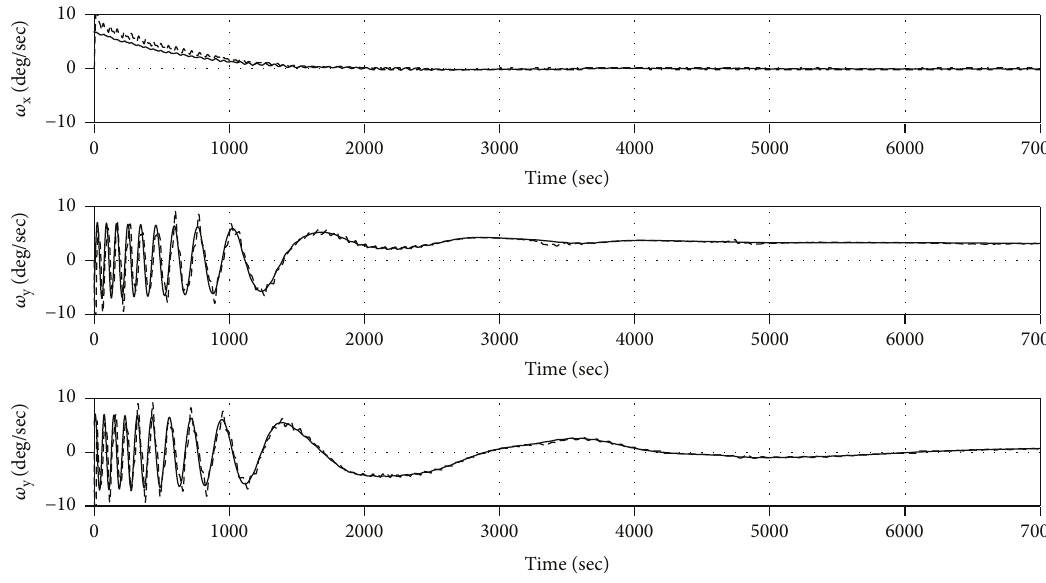
ω ω x , y , and z ) for a Y-Thompson spin